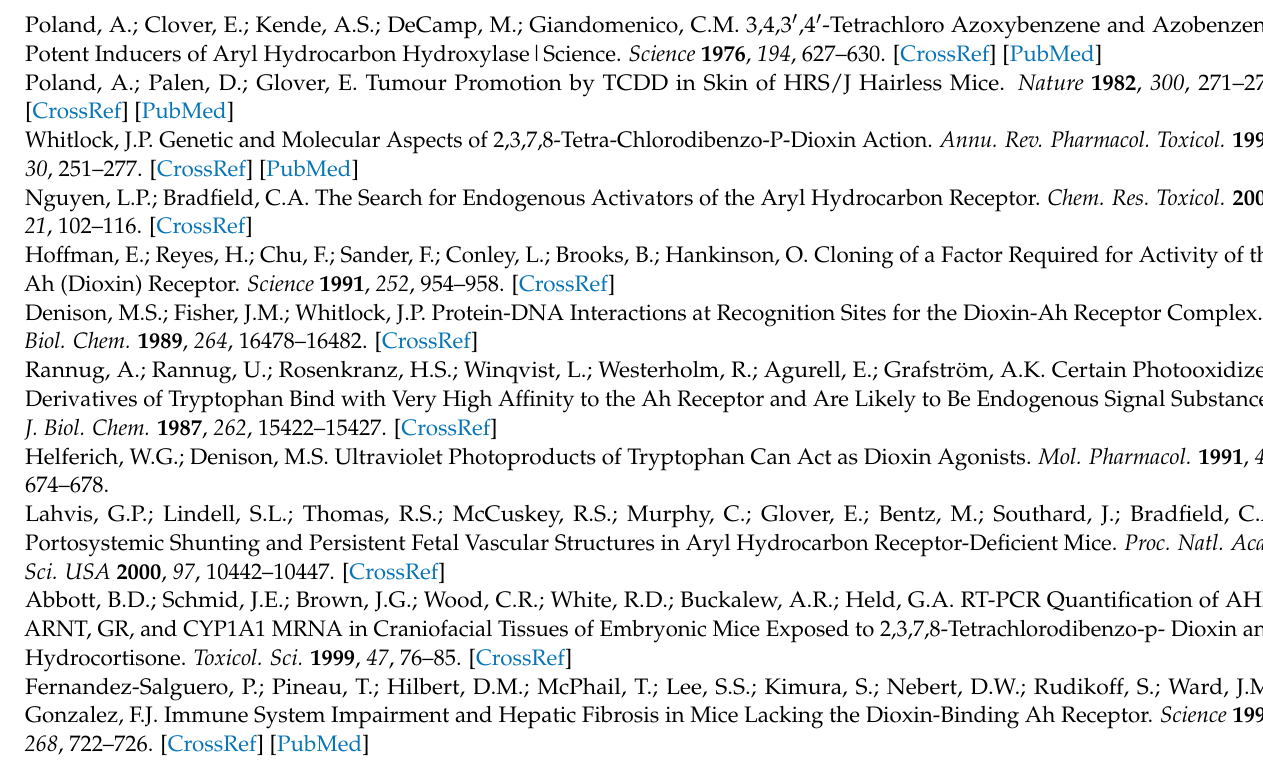
effect; Table S4: Primers used for the quantitative real-time polymerase chain